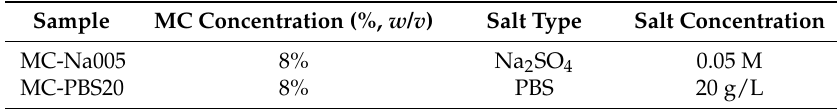
Table 1. Composition of the MC-based